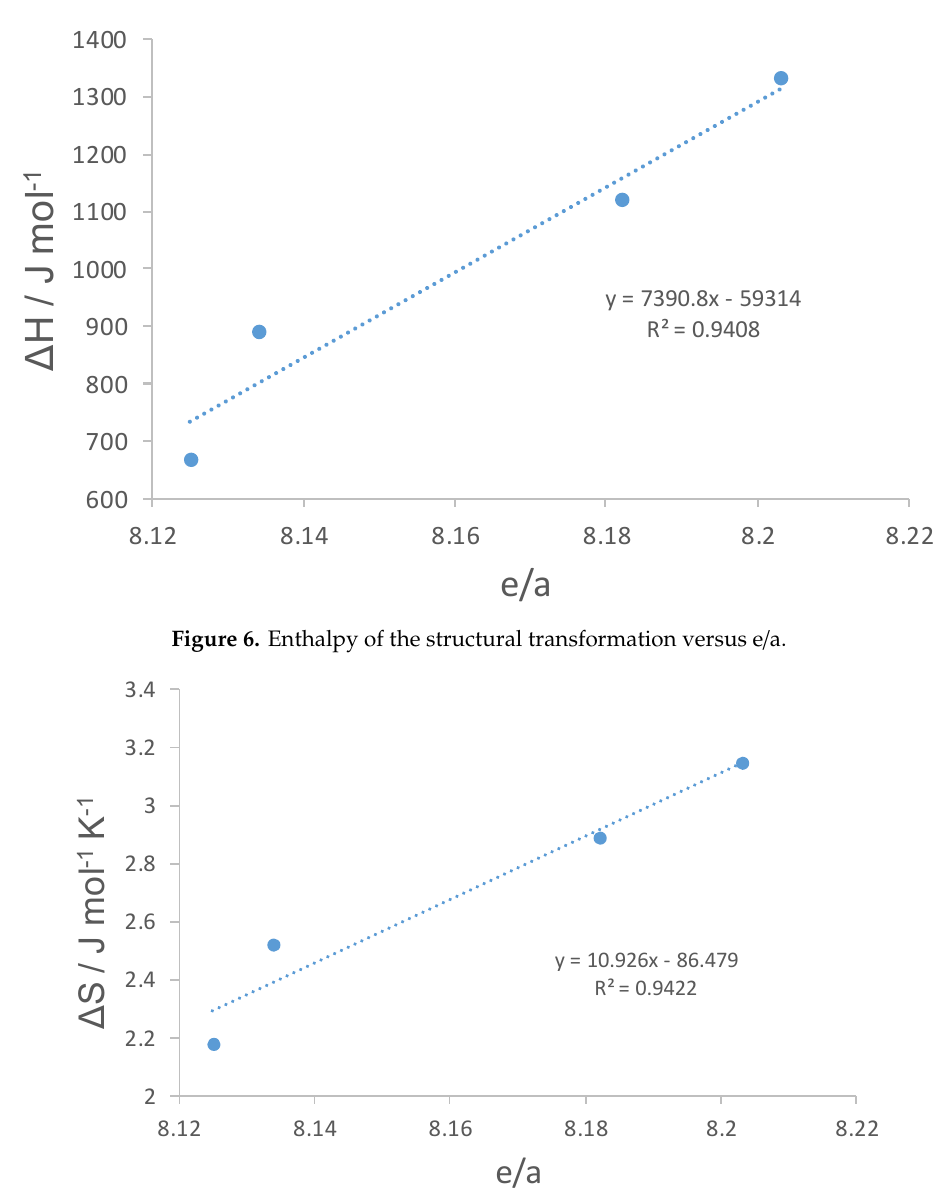
Figure 7. Entropy of the structural transformation versus average number of valence/outer electrons by atom (e/a).